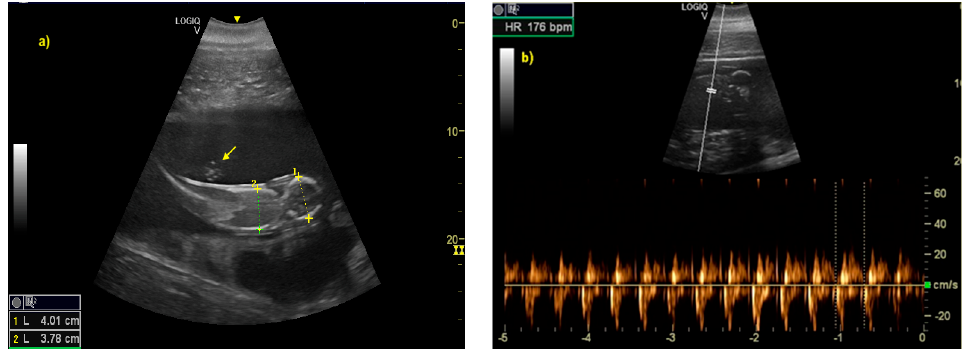
Figure 3. ( a ) The distinction between head and trunk was clear between 68 ± 5, up to the 216 ± 5 day of gestation. It allowed measurement of bi-parietal diameters. The umbilical cord was already easy guessed (as indicated by yellow arrow). ( b ) The fetal heart rate (HR) was measured once the cardiac mechanics became visible.